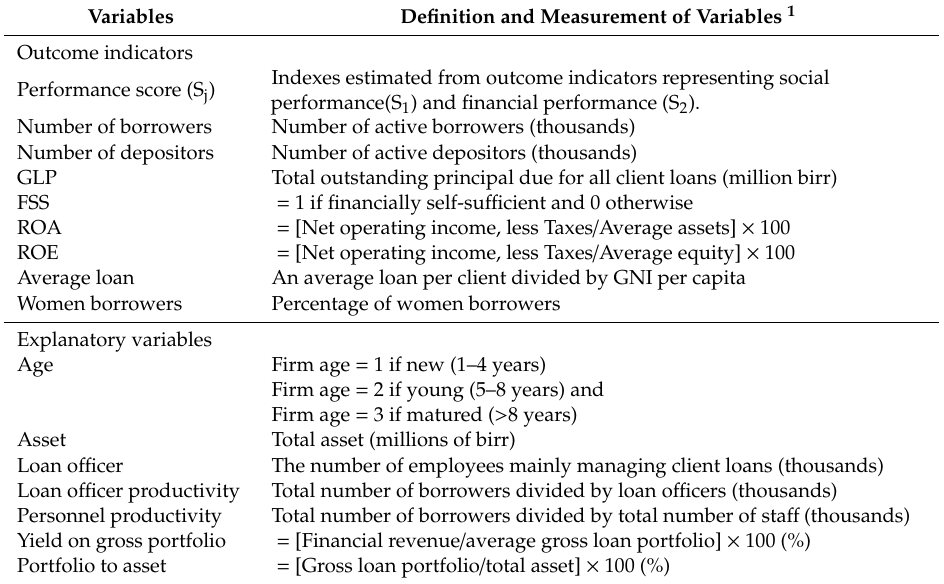
Table A1. Definition and measurement of variables.